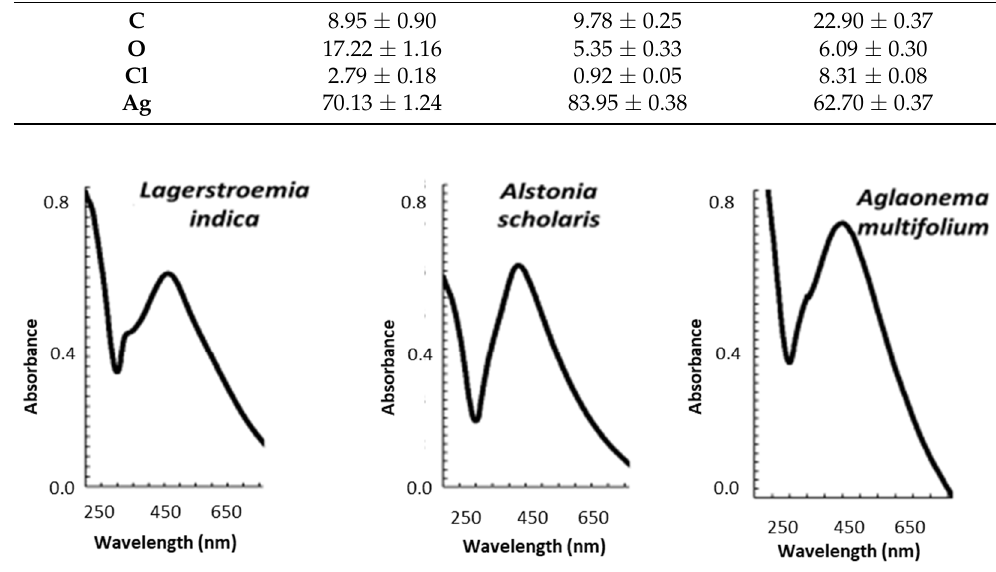
Figure 3. Characterization of AgNPs prepared using extracts from L. indica (LI), A. scholaris (AS), and A. multifolium (AM): Typical absorption spectra of each AgNPs. Other experimental details are in the section Material and Methods and Table 1.